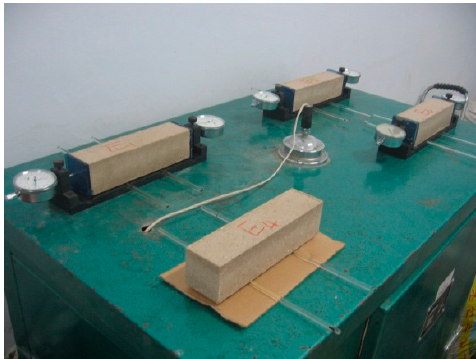
Figure 4. Drying shrinkage test.